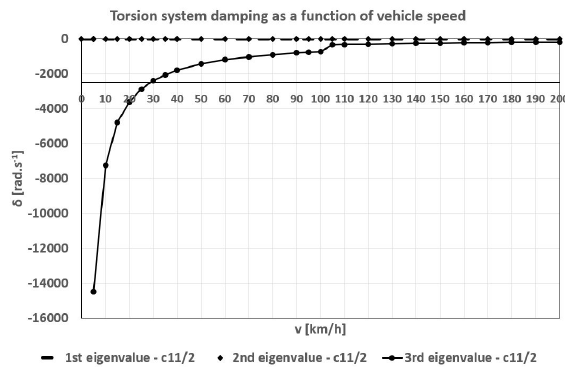
Figure 19. Damping as a function of velocity – c